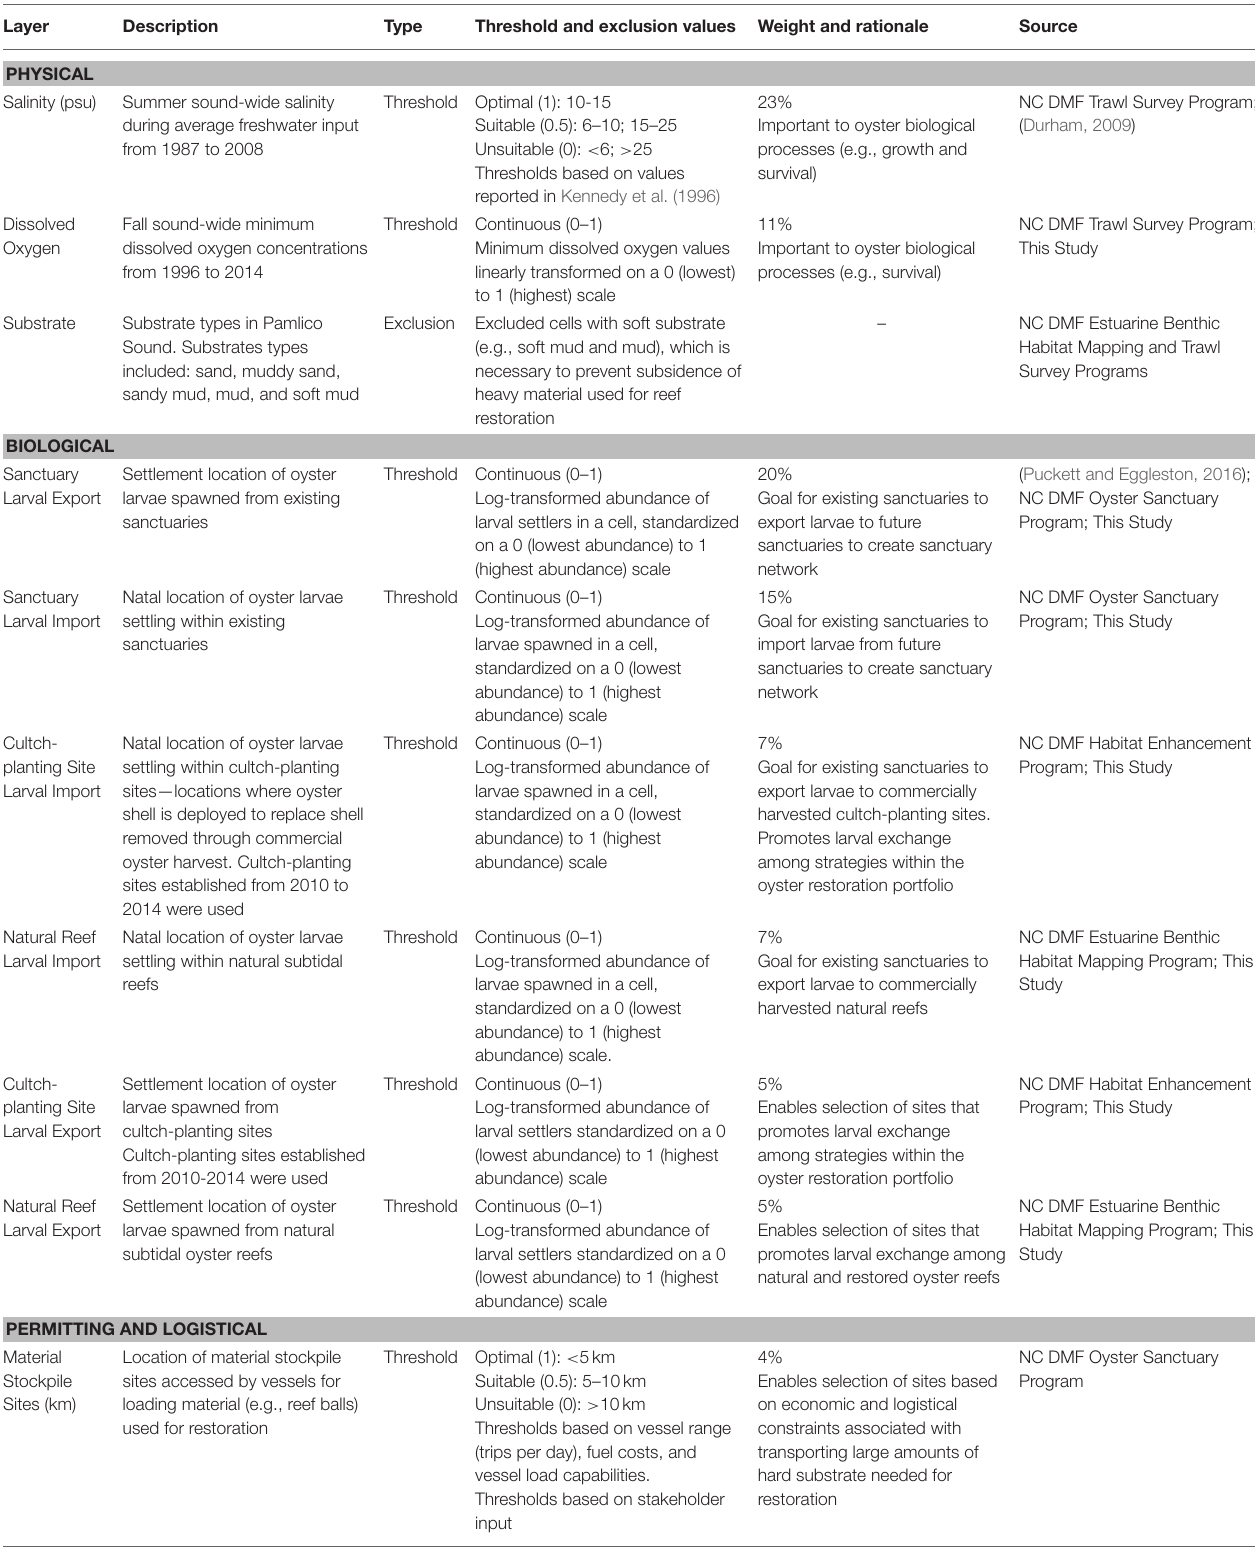
TABLE 1 | List of 17 GIS layers used in determining suitability of sites in Pamlico Sound for placement of oyster sanctuaries.